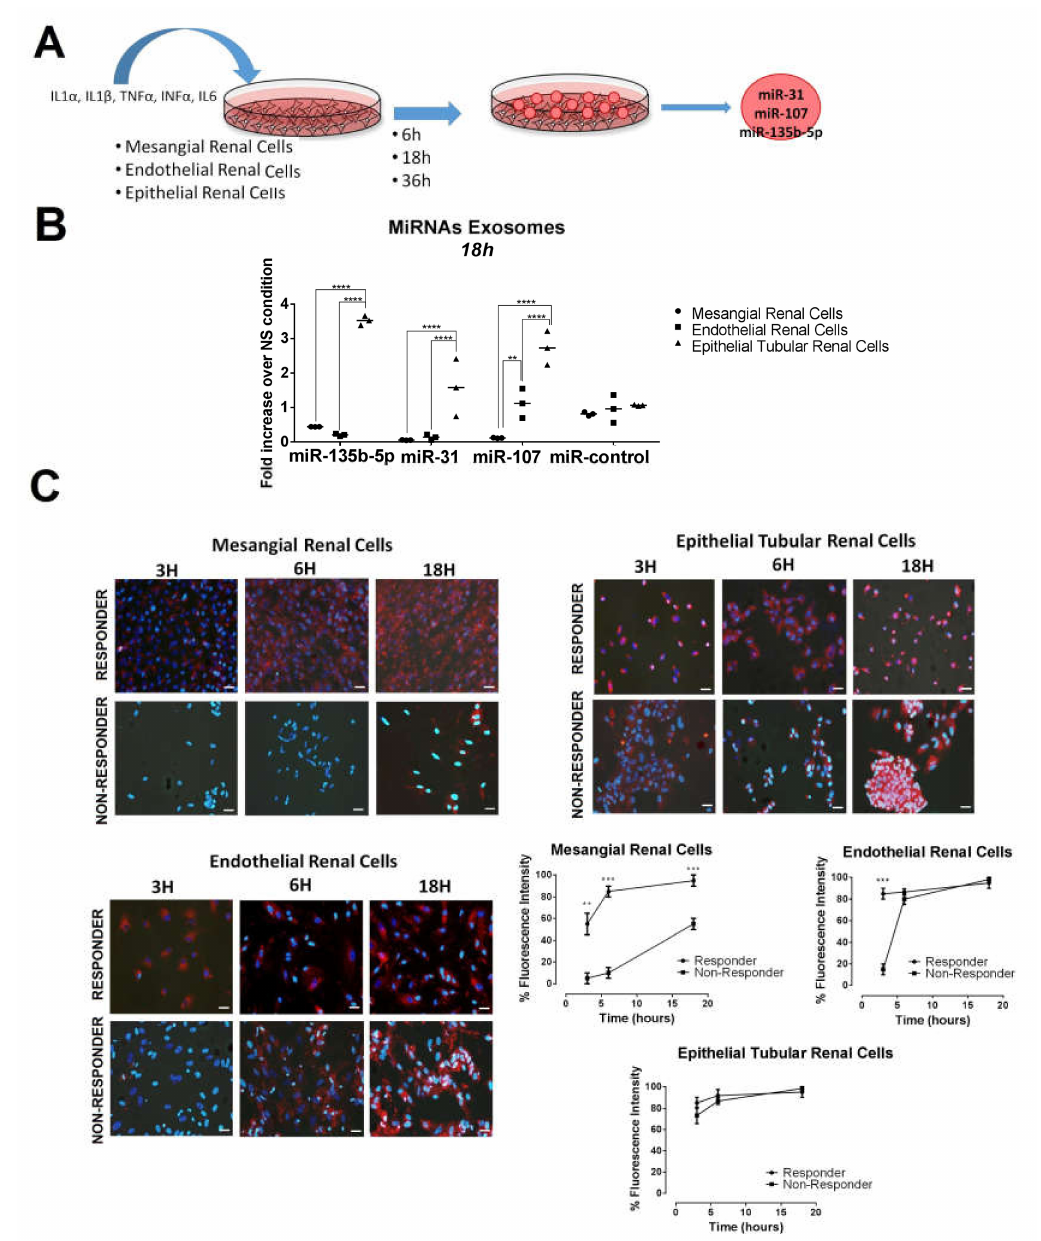
Figure 4. MiR-31-5p, miR-107, and miR-135b-5p urinary exosome origin and their target cell delivery. ( A ) Scheme of in vitro experiments performed to evaluate miRNA exosome production in mesangial, endothelial, and epithelial tubular renal cells. ( B ) After 18 h of stimulation, exosomes were obtained from studied renal cells to quantify their miRNA expression levels. Individual plots from n = 3 experiments. MiR-control is U6 small nuclear RNA. ( C ) Exosome internalization was measured by immunofluorescence in mesangial, endothelial, and epithelial tubular cells at di ff erent times. Blue color (DAPI) labels cell nuclei and red color labels exosomes. Each condition was assayed in triplicate. Error bars represent the means ± SEM from three independent experiments. Scale bar = 20 µ m. p -Values were obtained using two-way ANOVA test. ** p < 0.005; *** p < 0.0005; **** p <